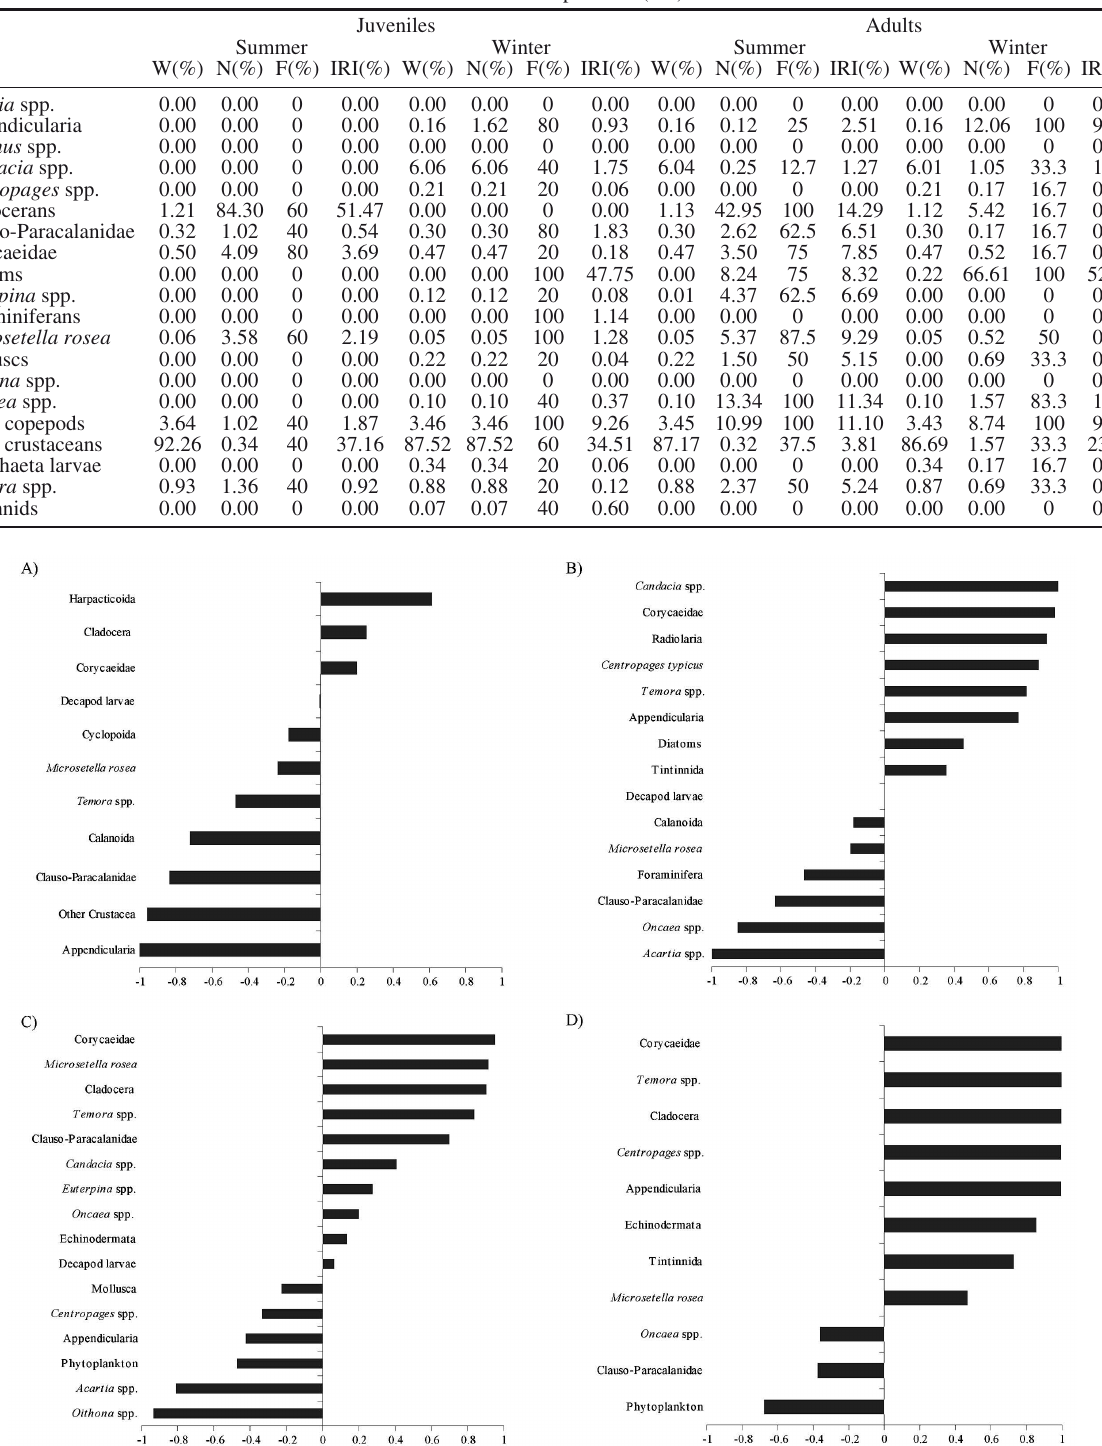
Fig. 5. – Ivlev’s dietary index. A, sardine juveniles summer; B, sardine juveniles winter; C, sardine adults summer; D, sardine adults